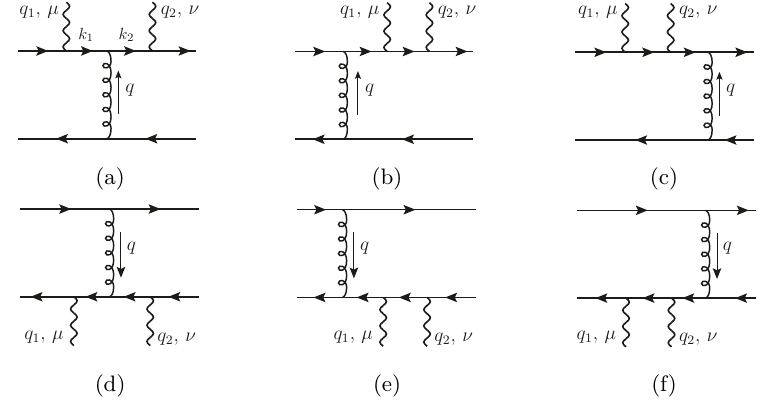
Figure 12. The Type- B diagrams, plus those with q 1 and q 2